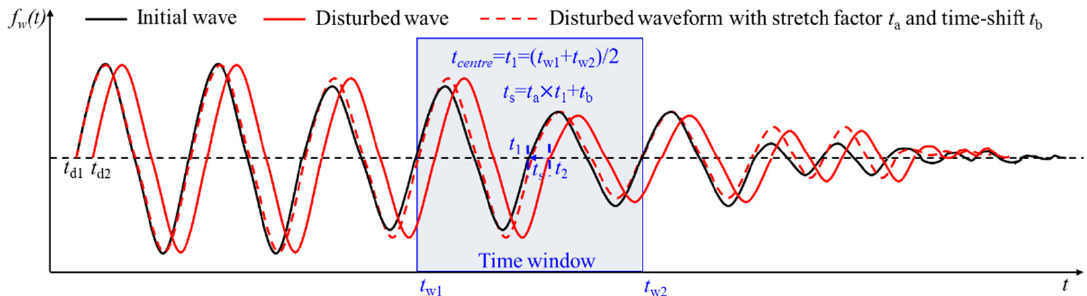
Figure 5. The waveforms before and after the medium change and the waveforms after stretching and translating in a time window.